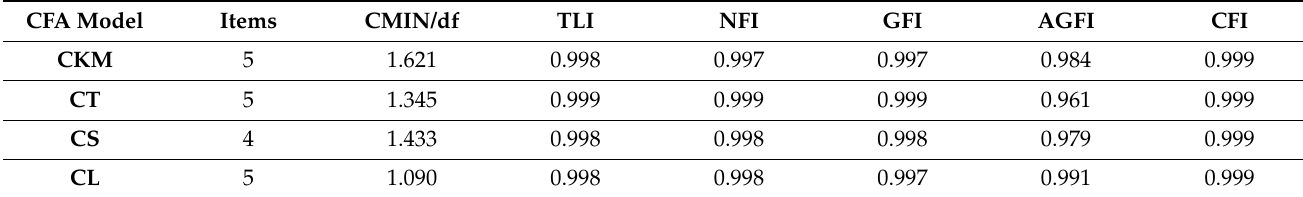
Table 4. Confirmatory factor analysis (CFA) of all measurement models.